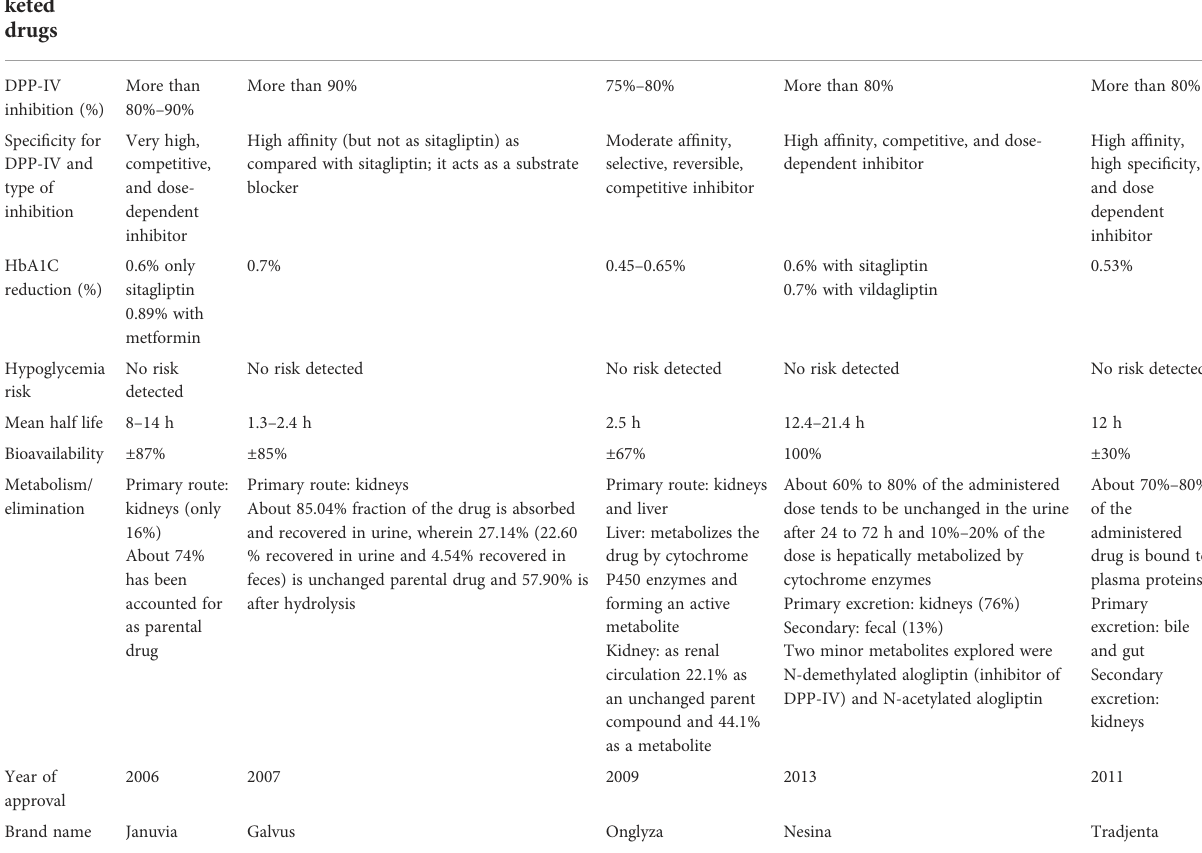
TABLE 1 Commercial dipeptidyl peptidase-IV